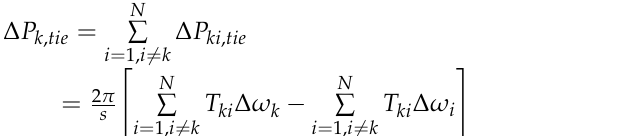
Figure 1. The suggested control block